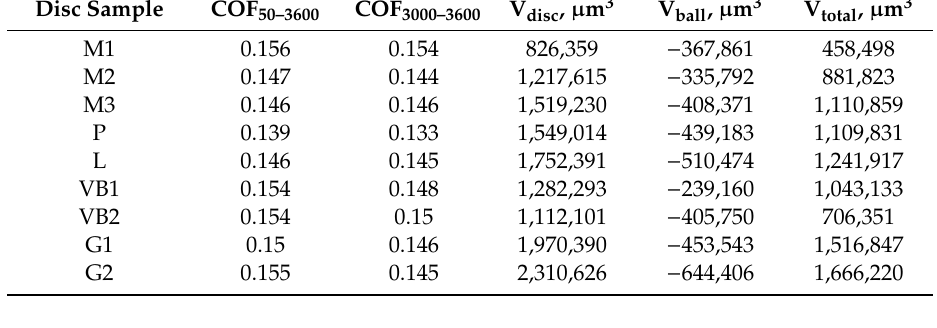
Table 6. Results of test C (f = 80 Hz, P = 100 N, temperature 30 ◦ C, the number of cycles 72,000).